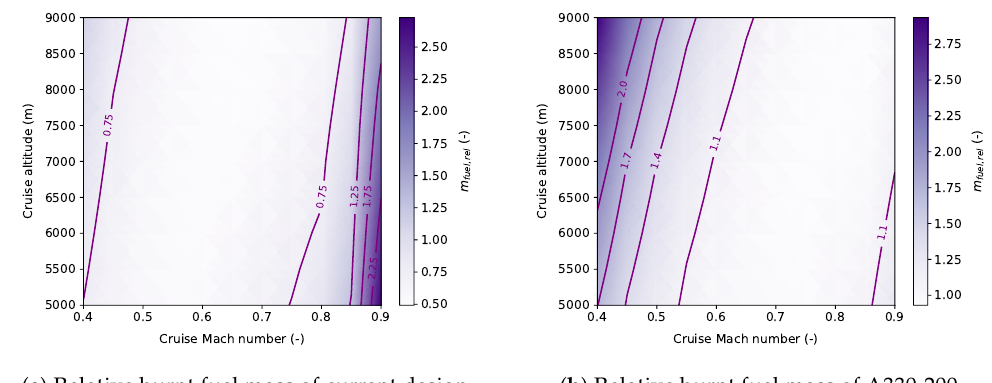
Figure 9. Variation of burnt fuel mass with Mach number and altitude (relative to A330-200 at Mach 0.82 and 11,250 m).